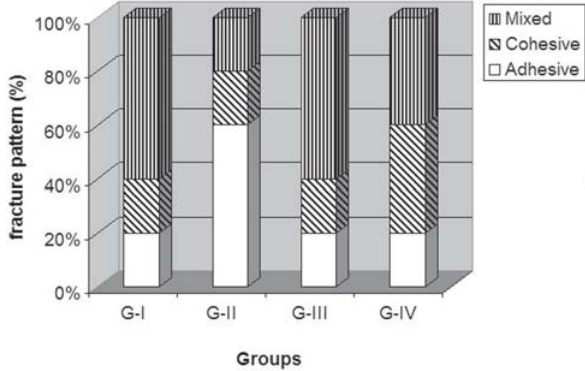
FIGURE 3- Failure modes (%) for the studied groups